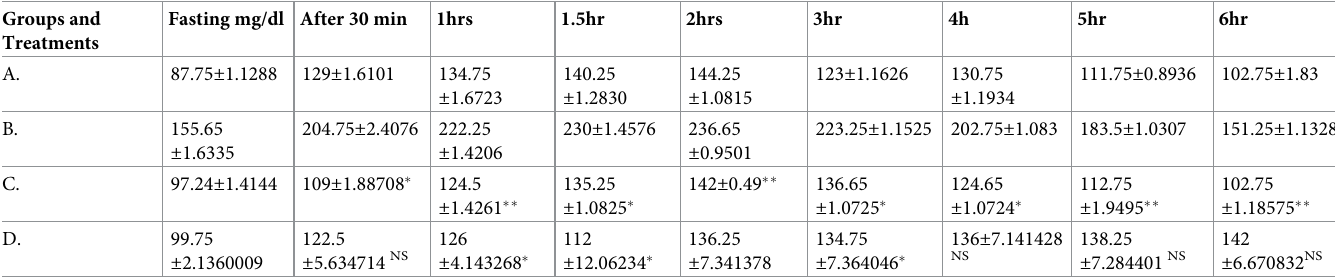
Table 3. Oral glucose tolerance test for antidiabetic activity of fruit of E . spinosa from AJK, Pakistan (blood glucose level mg/dl). Groups and Fasting mg/dl After 30 min Treatments